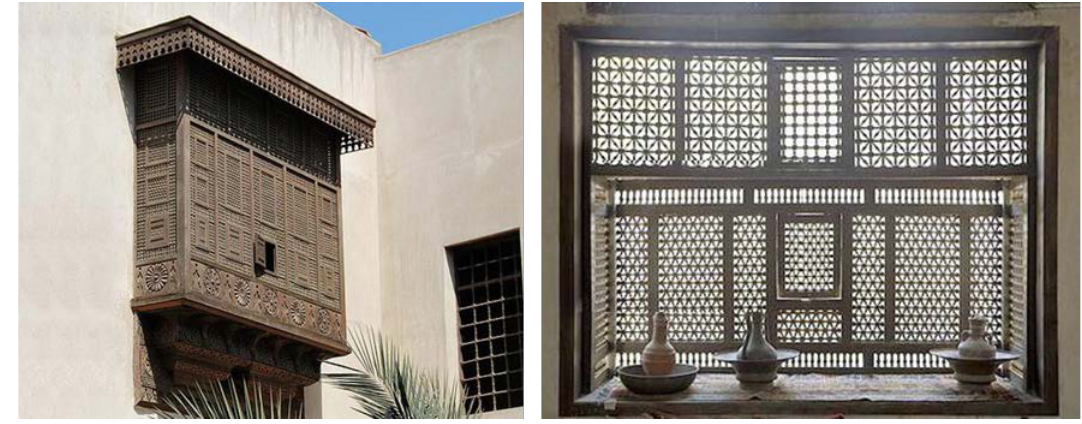
Figure 1. Example of a Mashrabiya in exterior shot (on the left) and in interior shot (on the right)